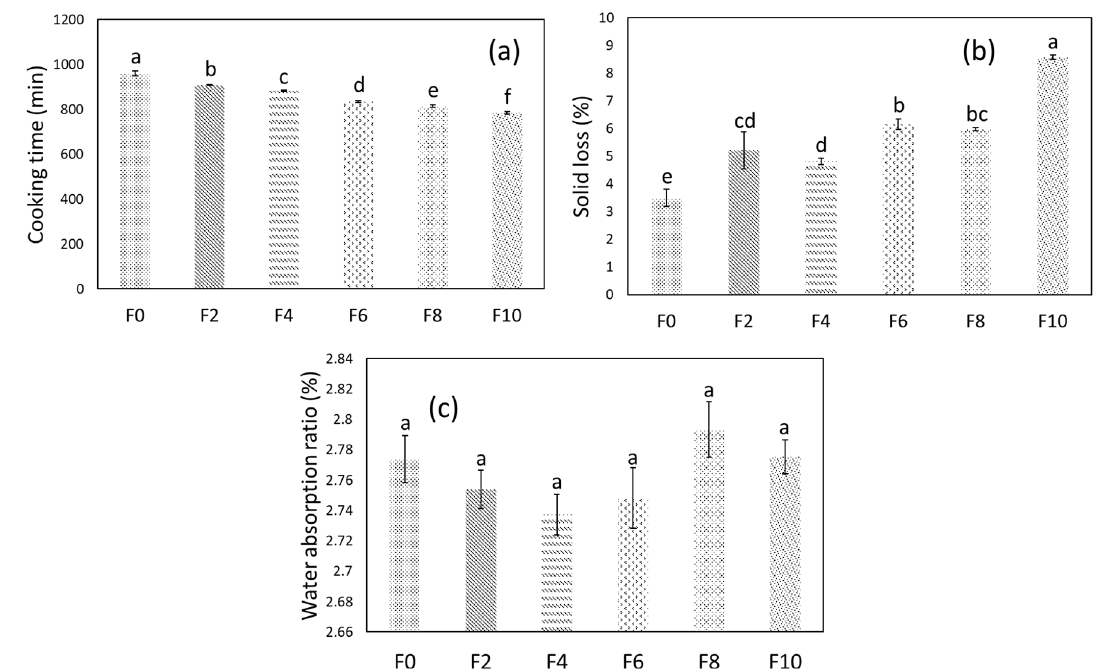
Figure 6 . Cooking characteristics of F0 and FRNs: ( a ) CT, ( b ) SL, and ( c ) WAR. Different letters on the top of the bar show significant differences ( p < 0.05). F0 represents 0% MLP, F2 represents 2% MLP, F4 represents 4% MLP, F6 represents 6% MLP, F8 represents 8% MLP, and F10 represents 10% MLP.